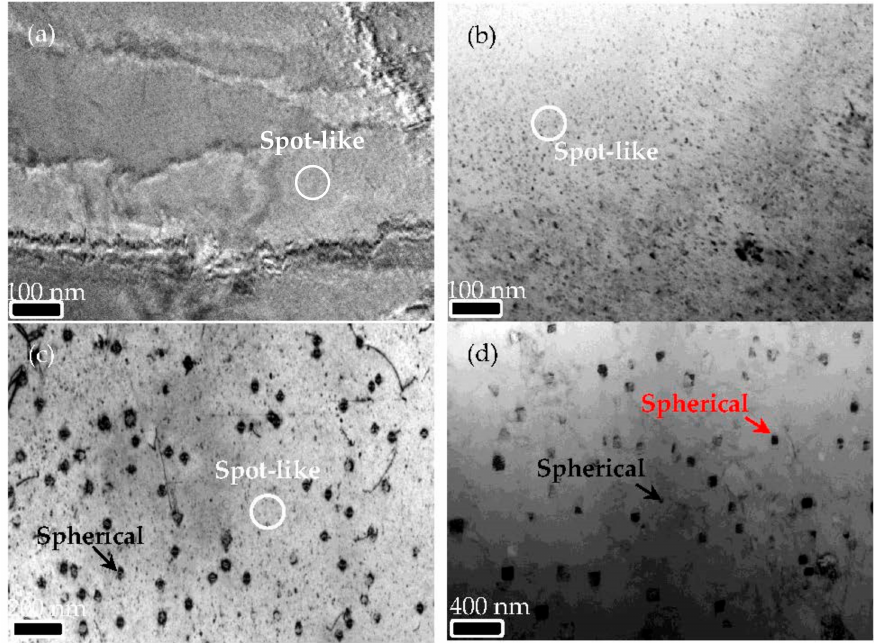
Figure 8. Bright-field TEM images showing the precipitates in ( a ) Cu-12Sn-1.5Ni; ( b ) Cu-12Sn-1.5Ni- 0.05Fe; ( c ) Cu-12Sn-1.5Ni-0.5Fe; ( d ) Cu-12Sn-1.5Ni-1.5Fe alloys